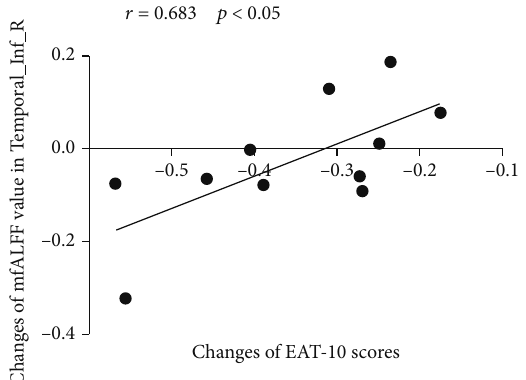
Figure 6: Analysis of the correlation between the change rate of mfALFF and swallowing function score in the inferior temporal